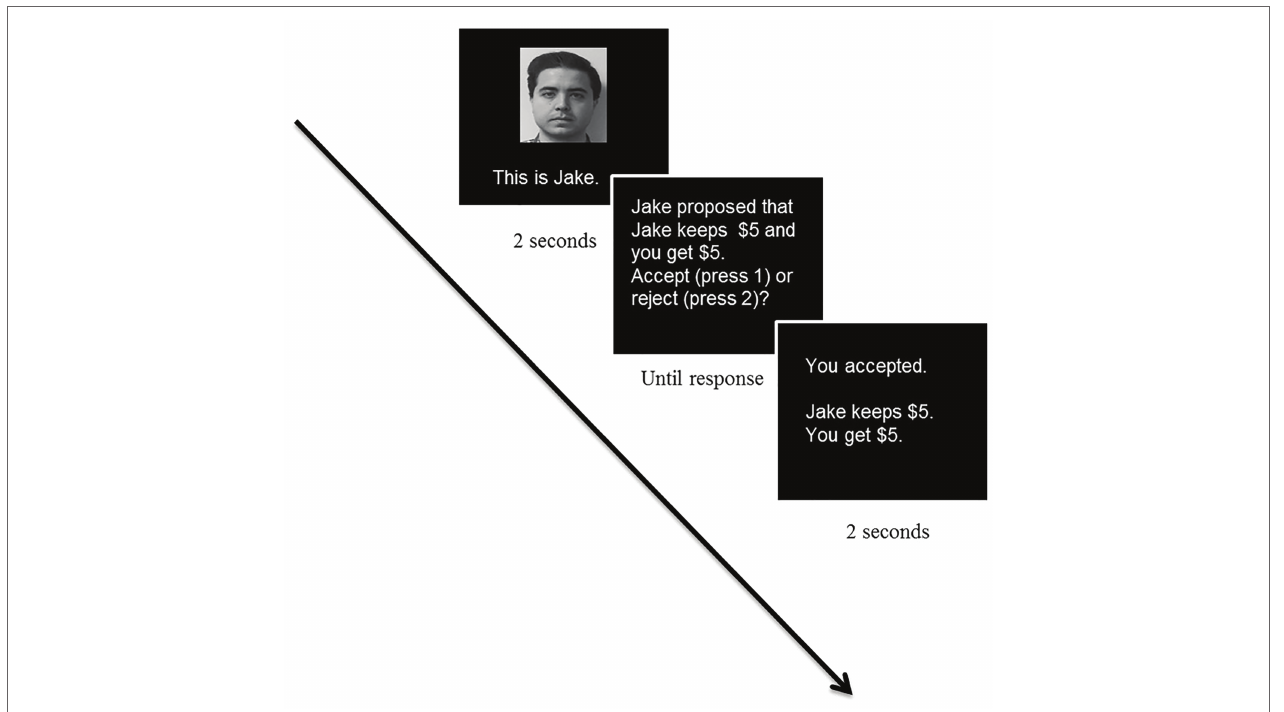
FIGURE 1 | Sample trial in the Ultimatum Game Task. Adapted from Park et al. (2019).